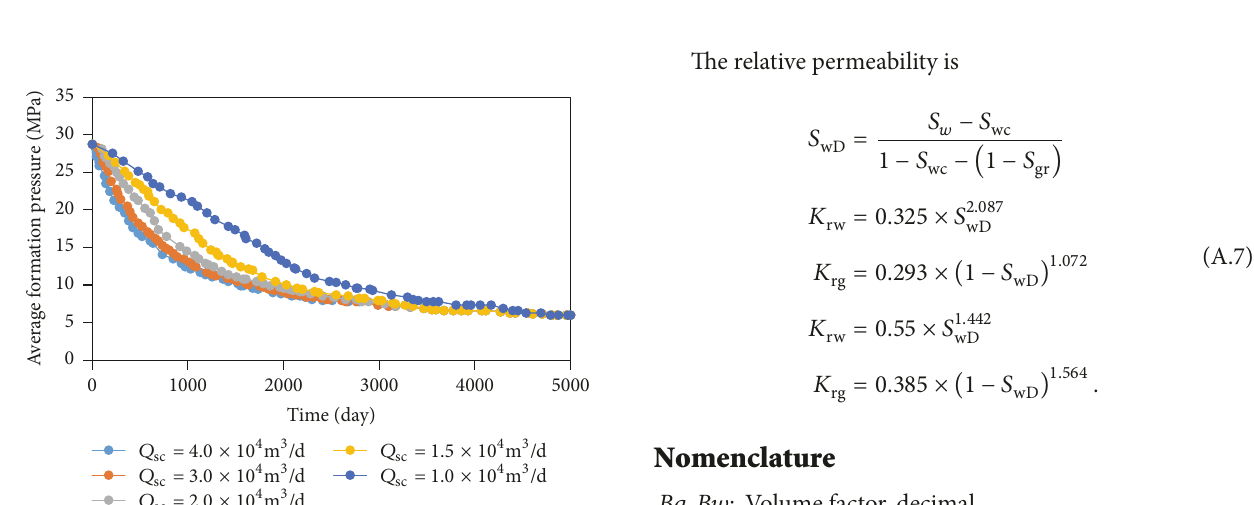
Figure 24: Gas recovery under different initial gas rates.